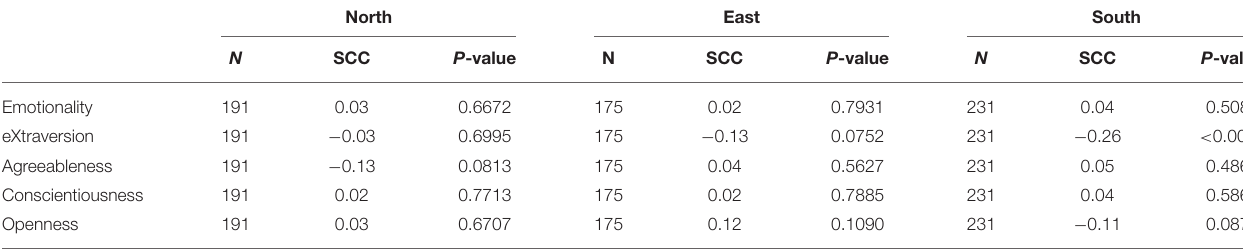
TABLE 7 | Spearman’s correlation analyses: Farmers’ Detection Index and farmers’ personality traits (HEXACO).